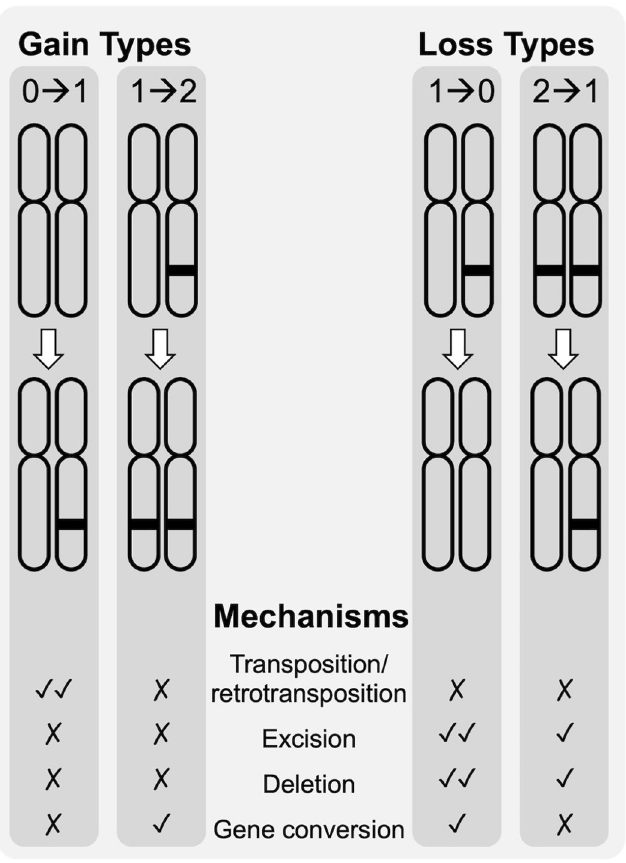
Fig 1. Categories of loss and gain for TE copies. Different mechanisms can explain the categories of loss and gain of TEs at a given locus (0 ! 1, 1 ! 2, 1 ! 0, and 2 ! 1) that occur in asexually-reproducing, diploid organisms like Daphnia magna . For each type of gain or loss, check marks indicate the qualitative, relative likelihood of a given mechanism and X marks indicate a particular mechanism cannot produce that type of gain or loss.